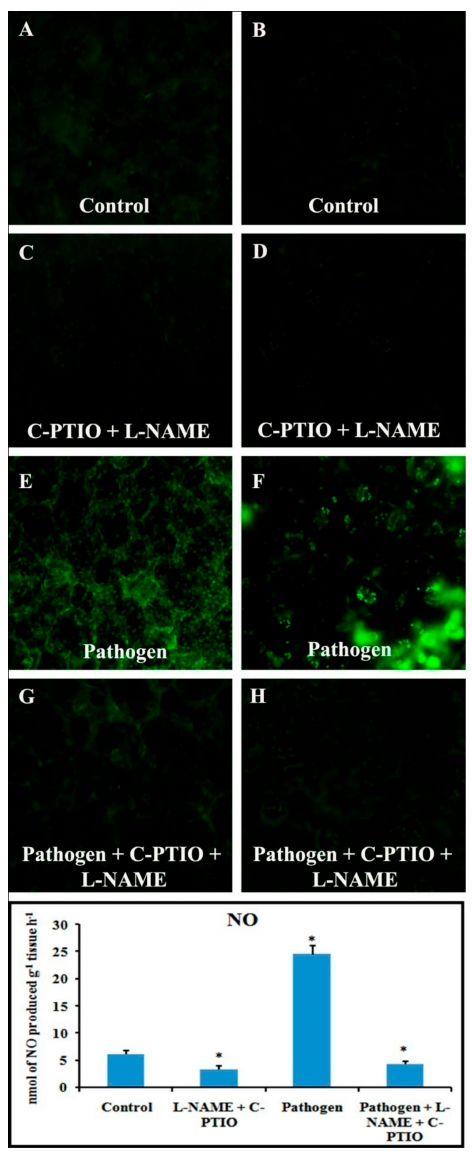
Figure 13. E ff ects of NO modulators on production of NO in detached bean leaf and petiole. Real-time NO generation was detected by green fluorescence in leaf epidermal cells stained by DAF-2DA: ( A , B ) Control; ( C , D ) at 2 dai; ( E , F ) at 4 dai. Leaf petiole ( A , C , E , G ) and lower epidermis of leaf ( B , D , F , H ). Graph represents spectrophotometric